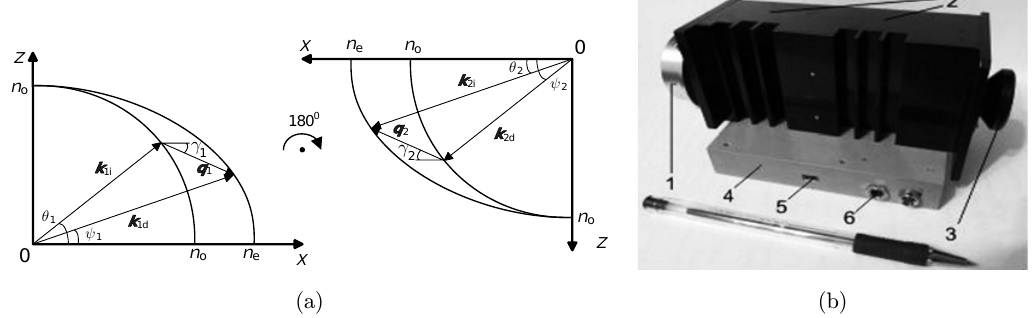
Note : q , k i , k d — wave vectors of ultrasound, incident and di®racted light; n o , n e — refractive indexes of crystal for ordinary and extraordinary polarized light. Fig. 1. Wave diagrams of the di®raction (a) and double-AOTF monochromator, (b) 1 — mechanical adapter for optical coupler, 2 — two AOTFs inside the cover, 3 — mechanical adapter for objective lens; 4 — driving radiofrequency unit; 5 — USB control port, 6 — power supply port.